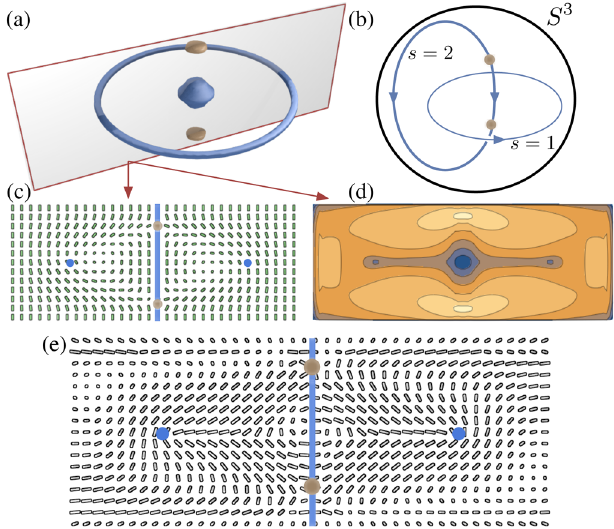
FIG. 3. Transient monopoles and umbilic lines observed in a simulated quench of the free energy [Eq. (1)]. Left: Contours of constant value of j Δ j . The blue lines are umbilics, the beige spheres are monopoles (point defects). Each umbilic has winding n ¼ 1 . They are all oriented similarly, so that the sum of the umbilics entering (leaving) the negative (positive) point defect is 4, in accordance with Eq. (20) and corresponding to the Skyrmion created between the monopoles. Top right: Cross section showing n on the shaded plane. As a map from the plane to S 2 , it has degree 1, indicating the presence of a Skyrmion. Bottom right: Contour plot showing the magnitude of log ðj Δ jÞ on the shaded plane; the umbilics are clearly picked out.